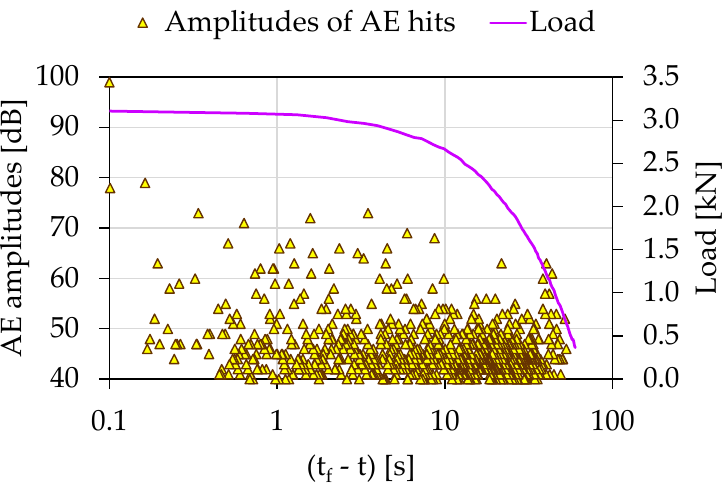
Figure 11. The temporal evolution of the AE amplitudes in juxtaposition to the load applied for the experiment Exp-HR in terms of the “time-to-failure” parameter.